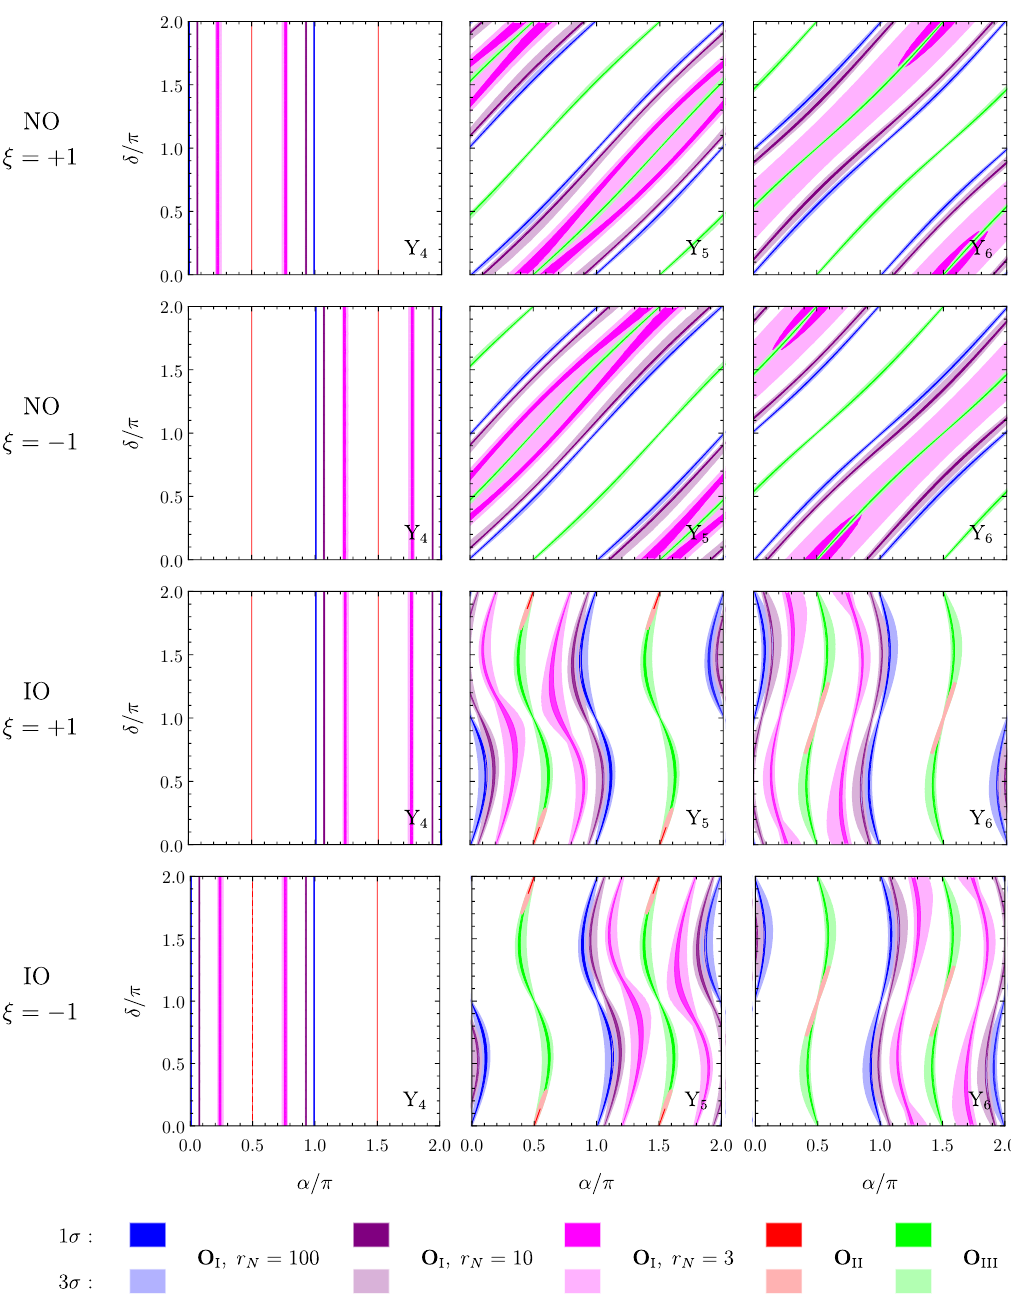
Figure 2 . Allowed regions in the ( (cid:11) , (cid:14) ) plane for all (R 2 ,Y 4 (cid:0) 6 ) combinations, both for NO (upper plots) and IO (lower plots), and (cid:24) = (cid:6) 1. The light (dark) coloured regions were obtained varying (cid:18) ij and (cid:1) m 2 within the 3 (cid:27) (1 (cid:27) ) experimental ranges given in table 1. In blue, purple, magenta, ij red and green we show the results for the cases in which O is of the type O I for r N = 100, O I for r N = 10, O I for r N = 3, O II and O III , respectively.